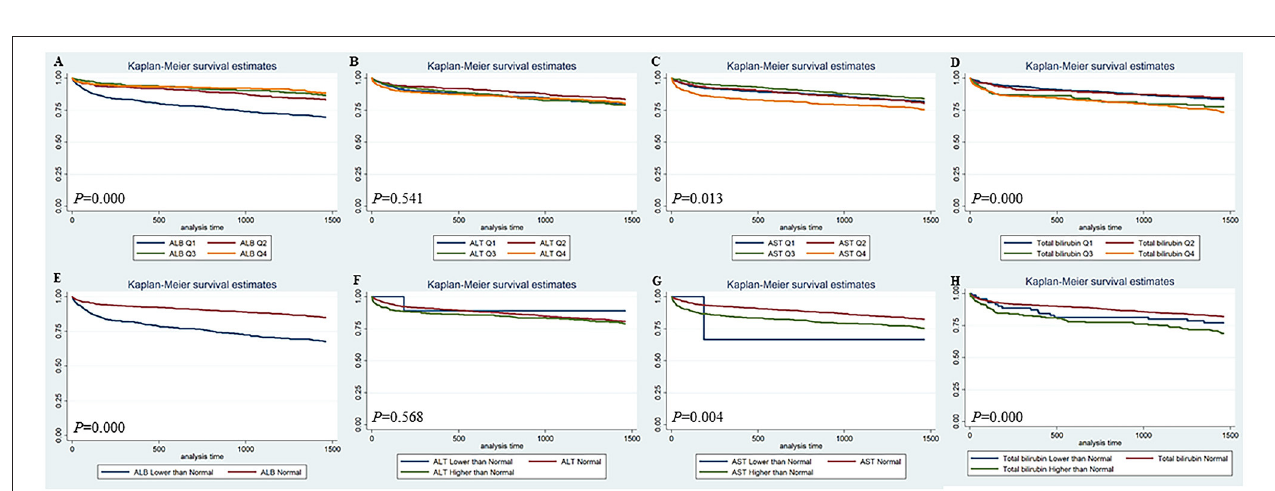
FIGURE 2 | Kaplan-Meier 4-year survival curves comparing patients by liver function index levels. Q, Quartile of serum ALB, ALT, AST and total bilirubin value; Normal, clinical normal value; ALB, blood albumin; ALT, blood alanine transaminase; AST, blood aspartate transaminase.